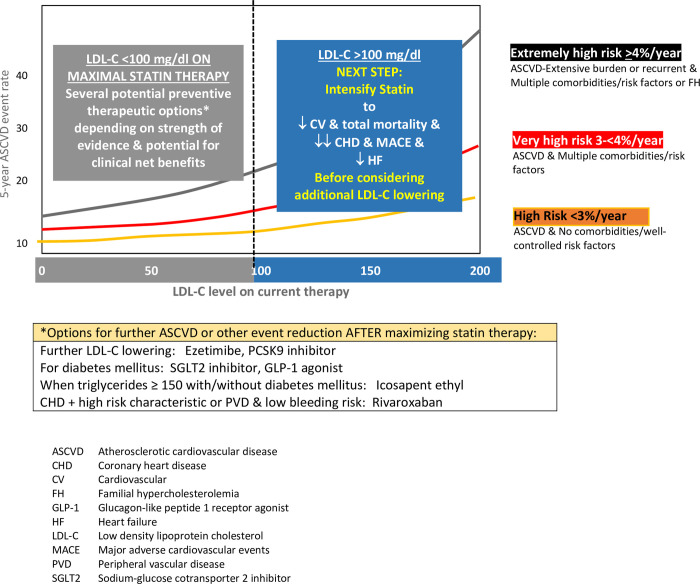
Priorities for adding cardiovascular risk reduction therapies guided by LDL-C above or below 100 mg/dl on maximal statin and lifestyle therapy in patients with ASCVD.When LDL-C levels are above 100 mg/dl, log linear association evidence for higher ASCVD risk groups and ASCVD risk reductions are substantial. When LDL-C is less than 100 mg, those patient groups with an extensive burden of atherosclerosis and multiple comorbidities, including familial hypercholesterolemia, are likely to have the greatest risk reduction from LDL-C lowering therapy.